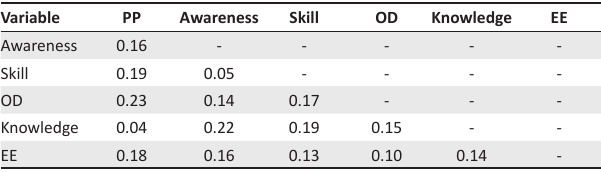
TABLE 9: Correlation coefficients of disaster risk management variables.